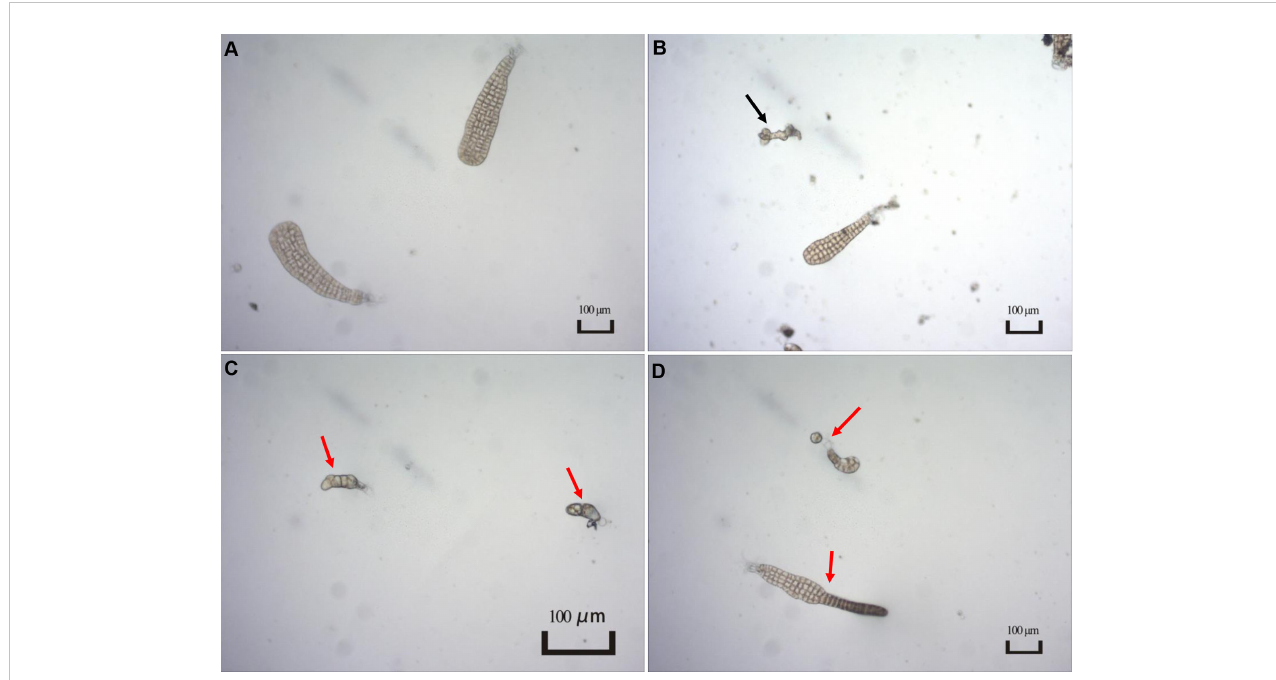
FIGURE 1 Typical characteristics of different types of seedlings observed in the present study. (A) Normal seedlings. Image from T15 group; (B) Individual not converted to sporophyte as indicated by a black arrow. Image from T10 group; (C, D) Malformed seedlings indicated by red arrows. Image from T15